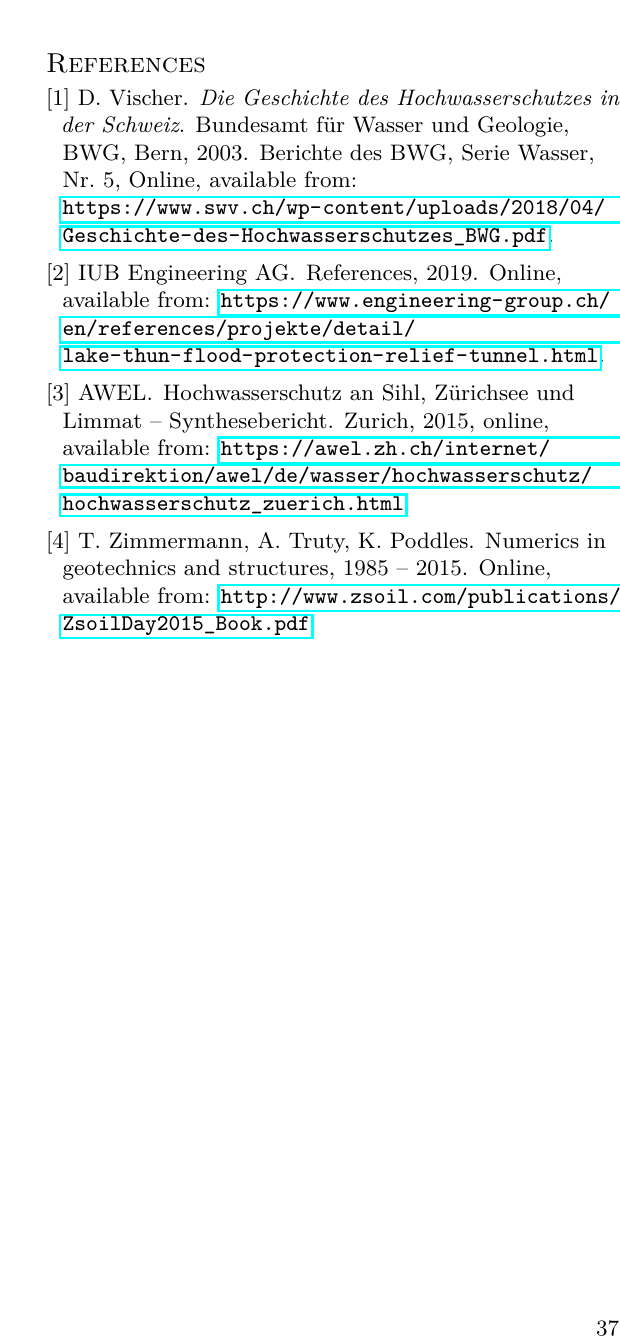
Figure 11. Crown failure in the gallery at FoSc = 1.18; colours of abs. displacements as